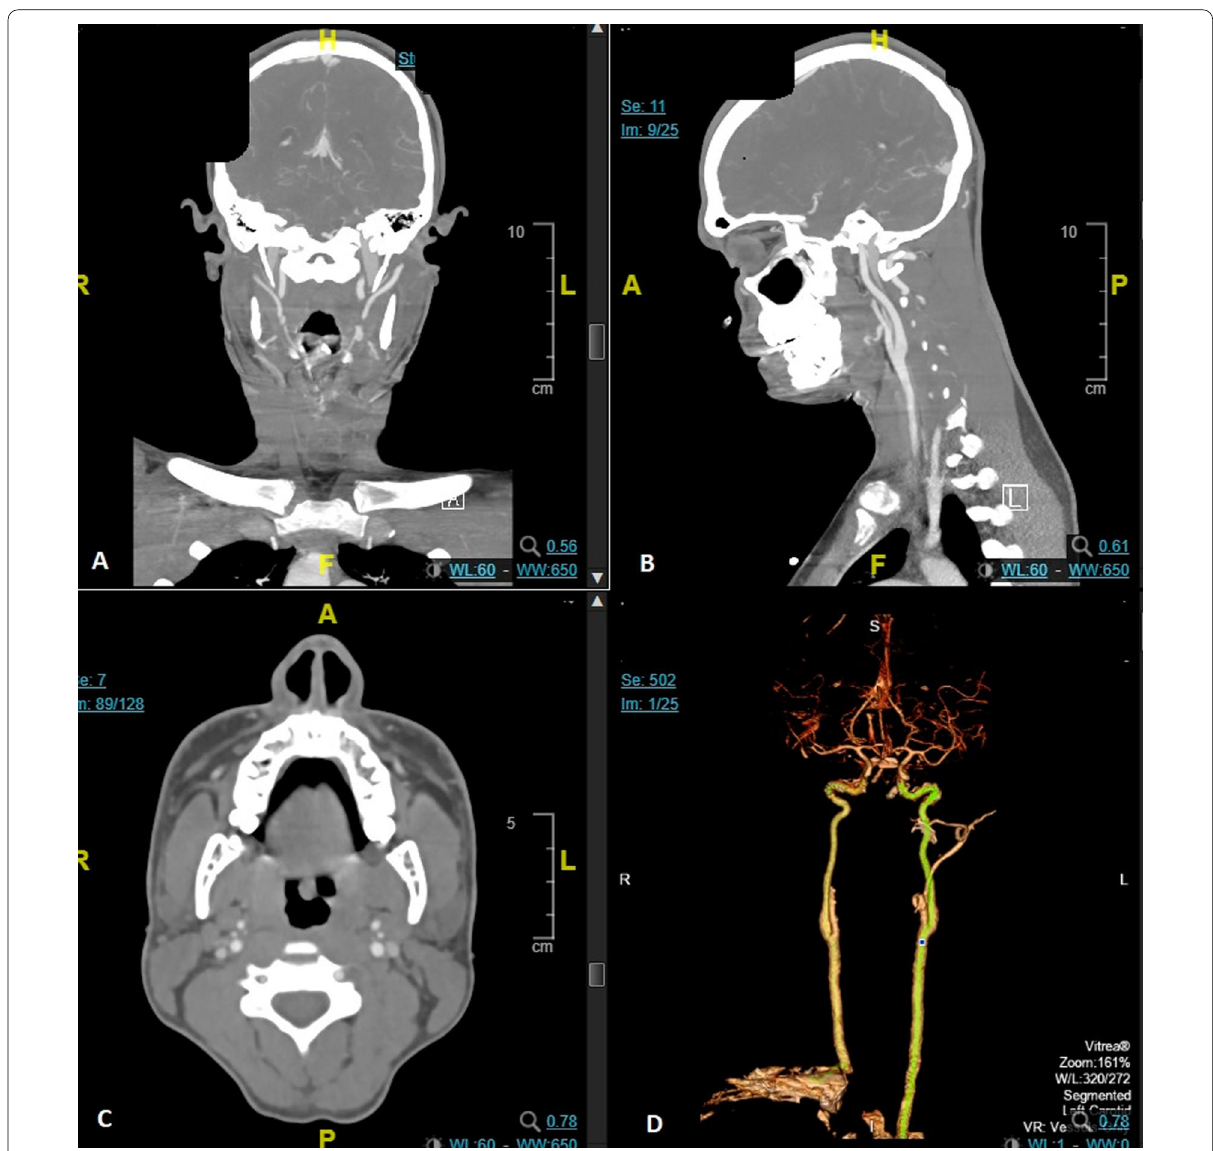
Fig. 2 A – C CT angiogram of the head and neck, showing no vascular lesions. D Maximal Intensity Projection (MIP), also demonstrating no vascular